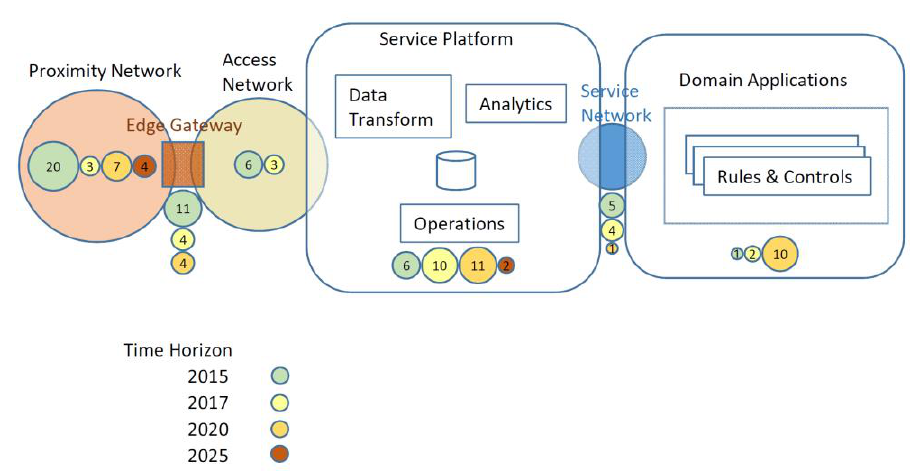
Figure 8. Landscape of Capabilities in relation to the architecture elements.